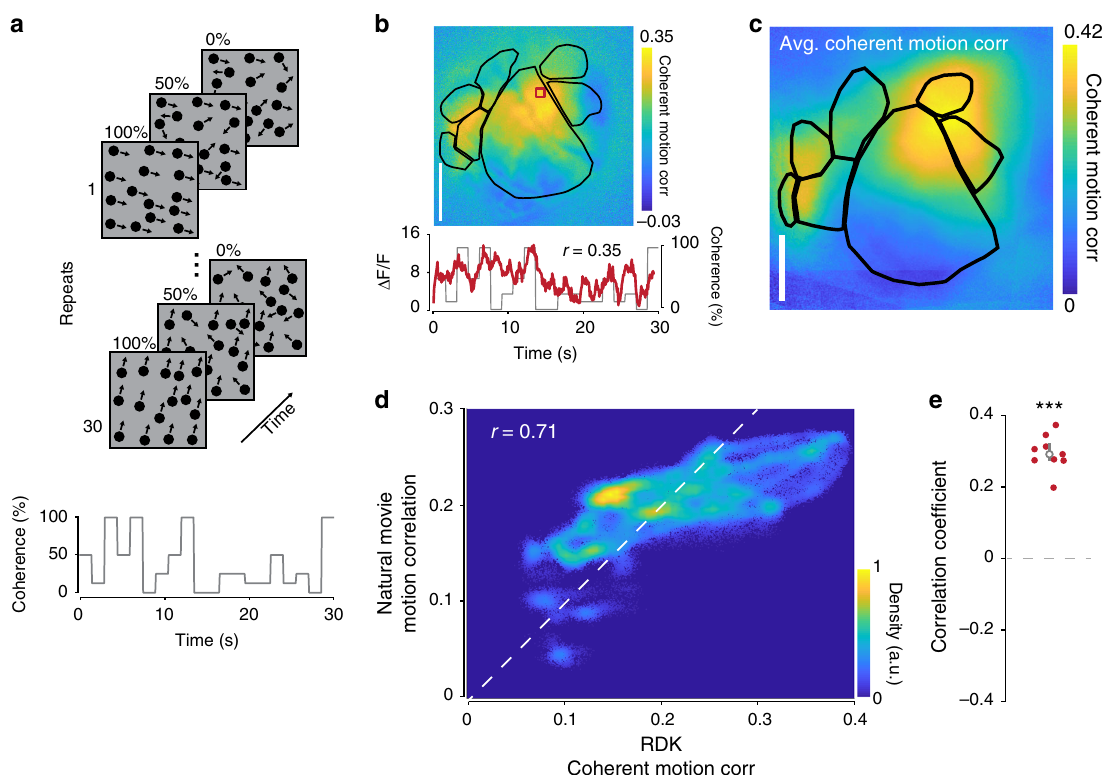
Fig. 2 Mesoscale calcium responses to coherent motion in RDKs. a Schematic of the RDK stimulus. A single repeat of the stimulus contains dots drifting at varying coherence values across the trial duration (bottom). Over multiple repeats, the coherence values remain constant while the dot positions and directions are randomized every trial. b Top: map from a single experiment showing coherent motion correlation to RDKs across posterior cortex. Bottom: single pixel response (red) over the course of a single presentation of the stimulus overlaid on the coherence value trace; pixel-wise coherent motion correlation is calculated as the Pearson correlation between these two signals ( r = 0.35). c Mean coherent motion correlation map across all imaged mice ( n = 10 sessions over 10 mice). Individual maps are transformed onto a common coordinate system for comparison across mice. d Pixel-wise density plot of RDK vs. natural movie motion correlation across all mice to show similarity of motion correlation across visual stimuli ( r = 0.71). Density plots are similar to scatter plots but provide additional information about the density (but not strength) at each coordinate, with warmer colors indicating a higher density of observation pairs (see Methods). e Natural movie versus RDK motion correlation for each mouse ( r = 0.30 ± 0.02, n = 10, p = 1.0 × 10 − 7 ; two-tailed single- sample t